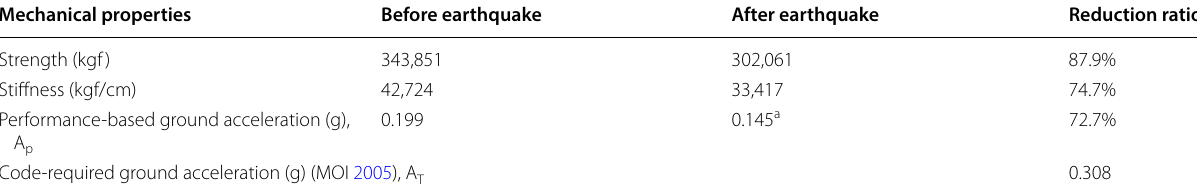
Table 12 Residual performance of seismic